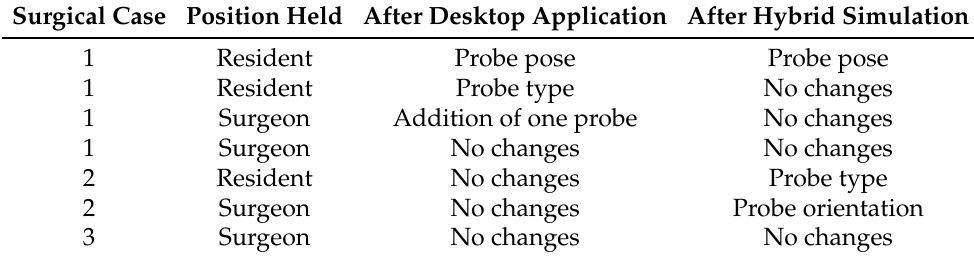
Table 3. Plan modifications after desktop and hybrid